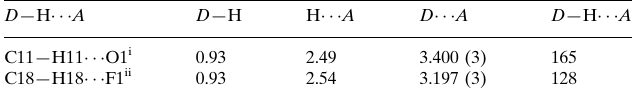
Hydrogen-bond geometry (A˚ , (cid:2)